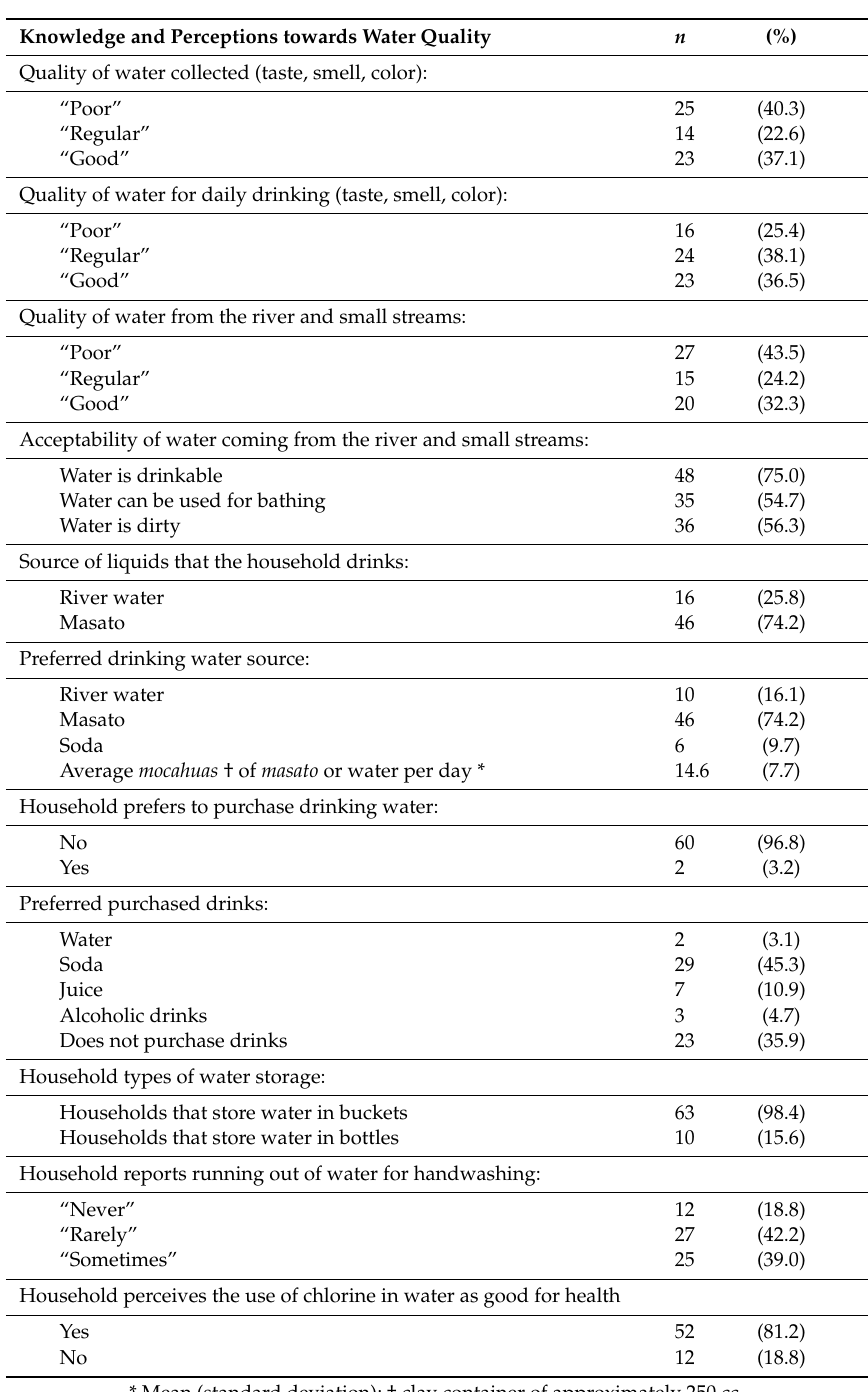
Table 2. The description of knowledge and perceptions towards water quality in the two Shawi communities, Peru ( n =